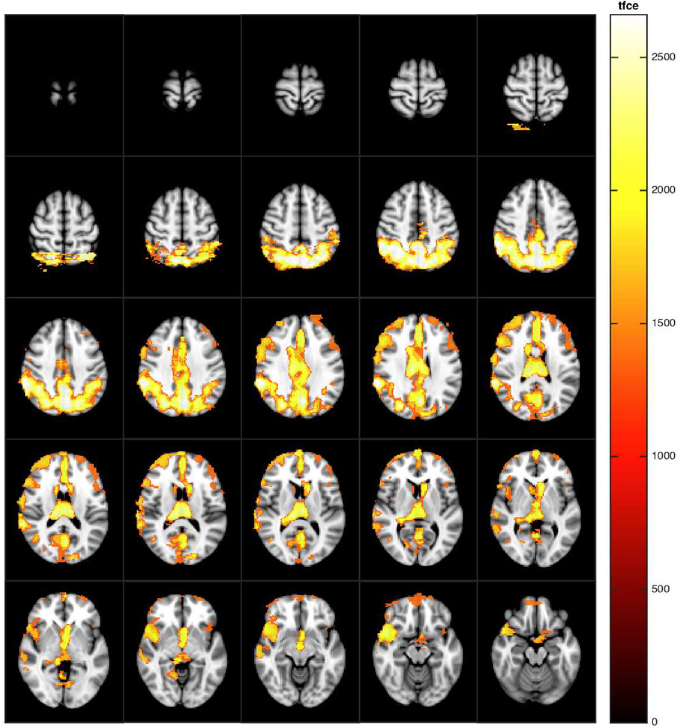
Fig 4. The relationship of brain parenchymal fraction with regional cerebral blood flow. Voxels in cerebralblood flow maps with significant(p < 0.05,corrected for multiplecomparisons) positive correlationwith brain parenchymal fraction, adjustedfor group, homocysteine and hemoglobin.